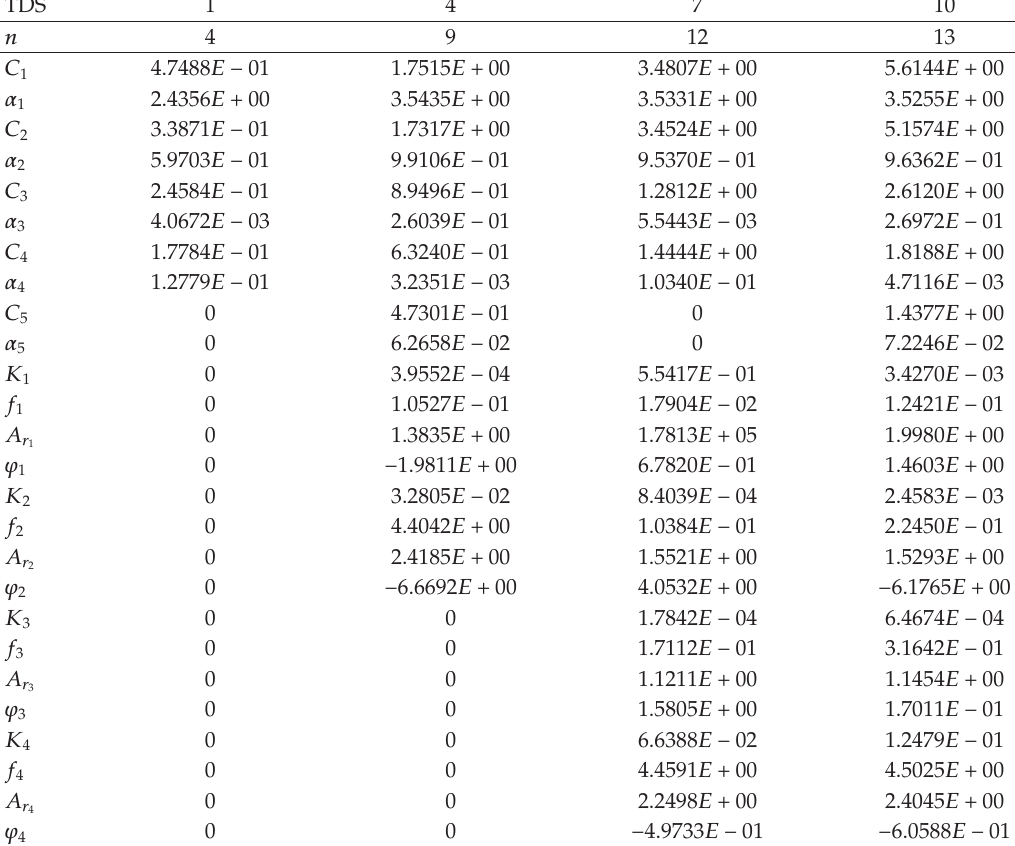
Table 1: The 26 parameters in (cid:3) 4.1 (cid:4) for the IAC51